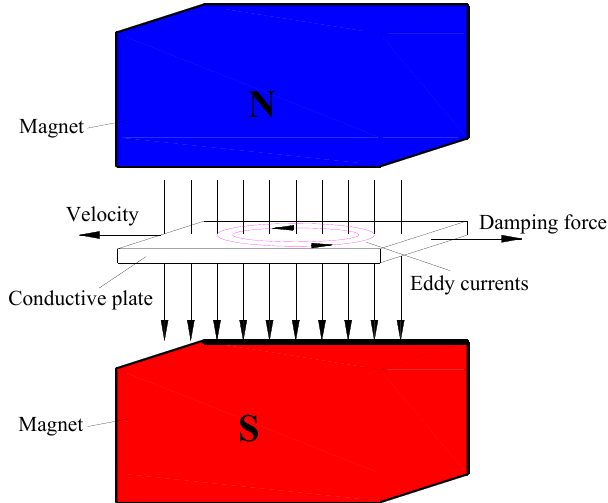
Figure 1. Generation of eddy current damping in a conductive plate.